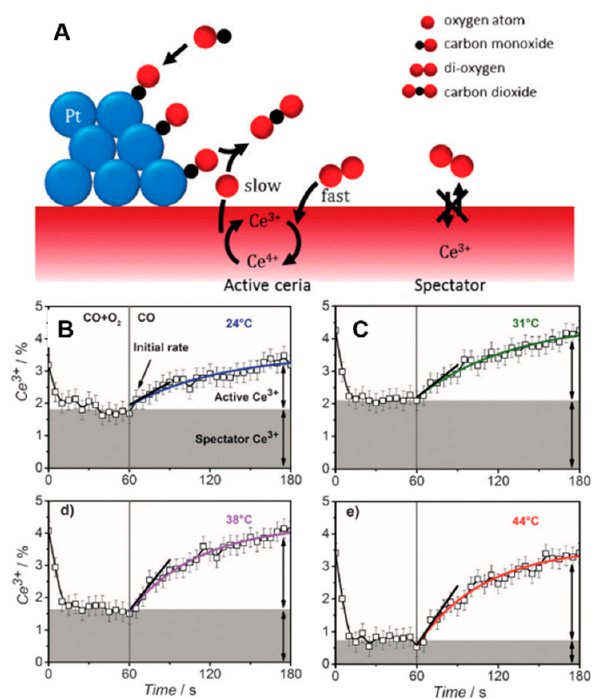
Figure 7. ( A ) Representation of oxygen uptake and release by ceria during the CO oxidation cycle on a Pt/CeO 2 catalyst. In the slow part of the cycle, an oxygen atom from ceria at the Pt–CeO 2 interface reacts with CO adsorbed on platinum to afford CO 2 , an oxygen vacancy, and two Ce 3+ species. The fast part of the cycle involves CO readsorption on platinum and oxygen activation on ceria resulting in healing of the oxygen vacancy and oxidation of active Ce 3+ species. Ce 3+ spectator species do not participate in CO oxidation. ( B – E ) Transient Ce 3+ concentrations in the Pt/CeO 2 catalyst measured with RXES during cycling between 1% CO+4% O 2 (0–60 s) and 1% CO (60–180 s) gas mixtures at 24, 31, 38, and 44 °C. The increase in Ce 3+ concentration in 1% CO was fitted by an exponent function and the initial rate at the moment of switching (60 s) was determined (indicated as the slope). The concentrations of active and spectator Ce 3+ species are indicated by arrows. Reprinted with permission from Reference [45]. Copyright 2015, John Wiley and Sons.